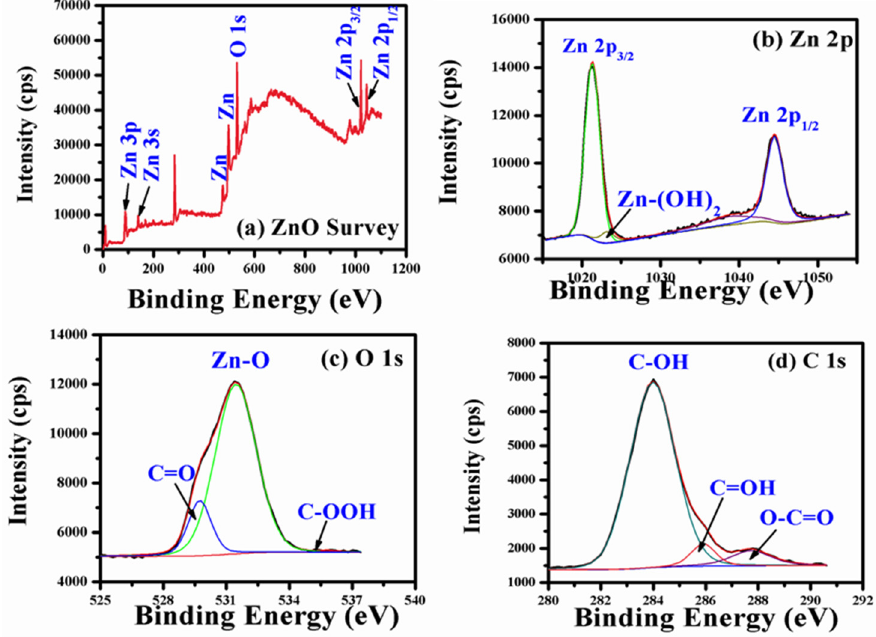
Figure 7. ( a – d ) XPS data of N-ZnO